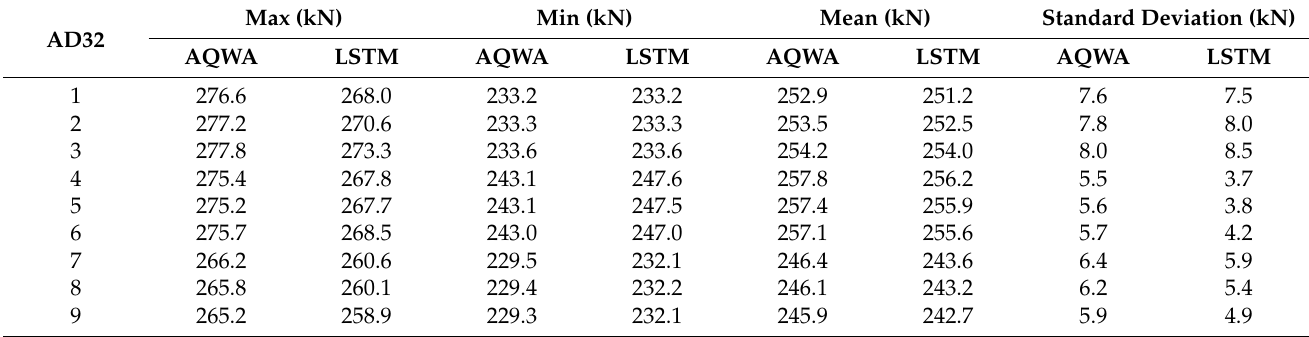
Table 16. Result statistics of